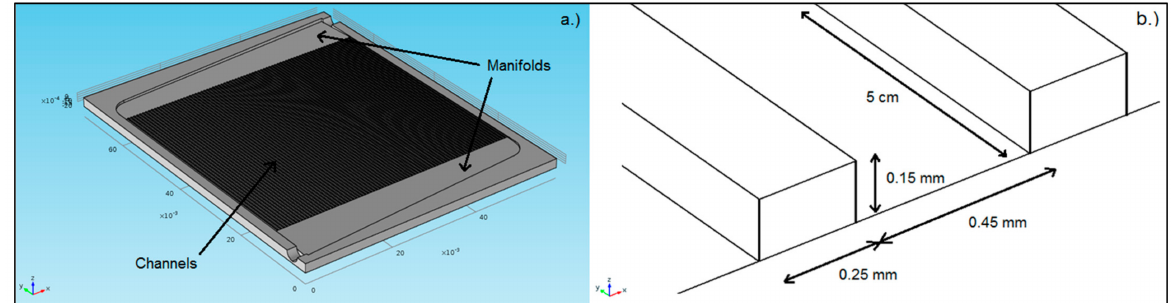
Figure 1. Illustrations of ( a ) the microchannel reactor plate with 80 microchannels and two fluid distribution manifolds chemically etched; ( b ) the dimensions of a single uncoated microchannel. Adapted with permission from N. Engelbrecht, S. Chiuta, R.C. Everson, H.W.J.P. Neomagus, D.G. Bessarabov, Chemical Engineering Journal; published by Elsevier, 2017